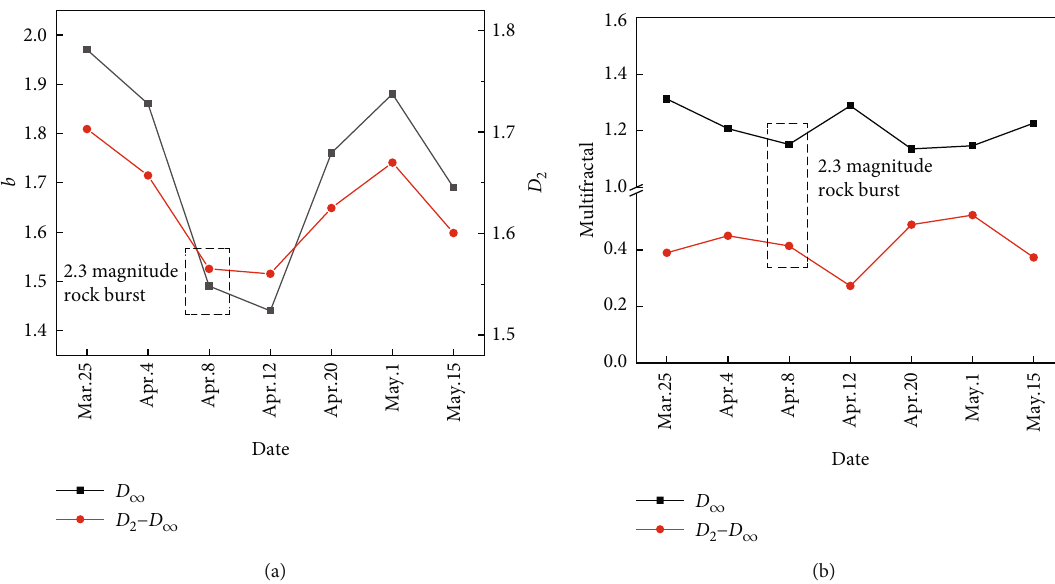
Figure 10: Time variation diagram of b value and multifractal of mine seismicity (a) b value and D